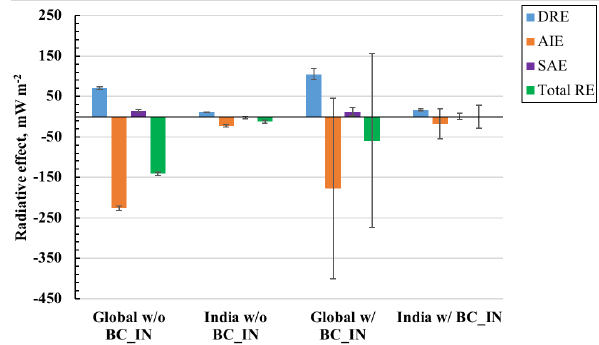
Figure 6. Radiative effect (RE) for global and Indian solid fuel cookstove aerosol emissions with BC not serving as IN (w/o BC_IN) and BC as IN (BC_IN), with DRE (blue), AIE (orange), SAE (purple) and total RE (green). Error bars represent one stan- dard deviation for each RE. For BC as IN, standard deviations of RE are solely based on the choices of maximum freezing efficiency of BC as 0.01, 0.05 and 0.1,